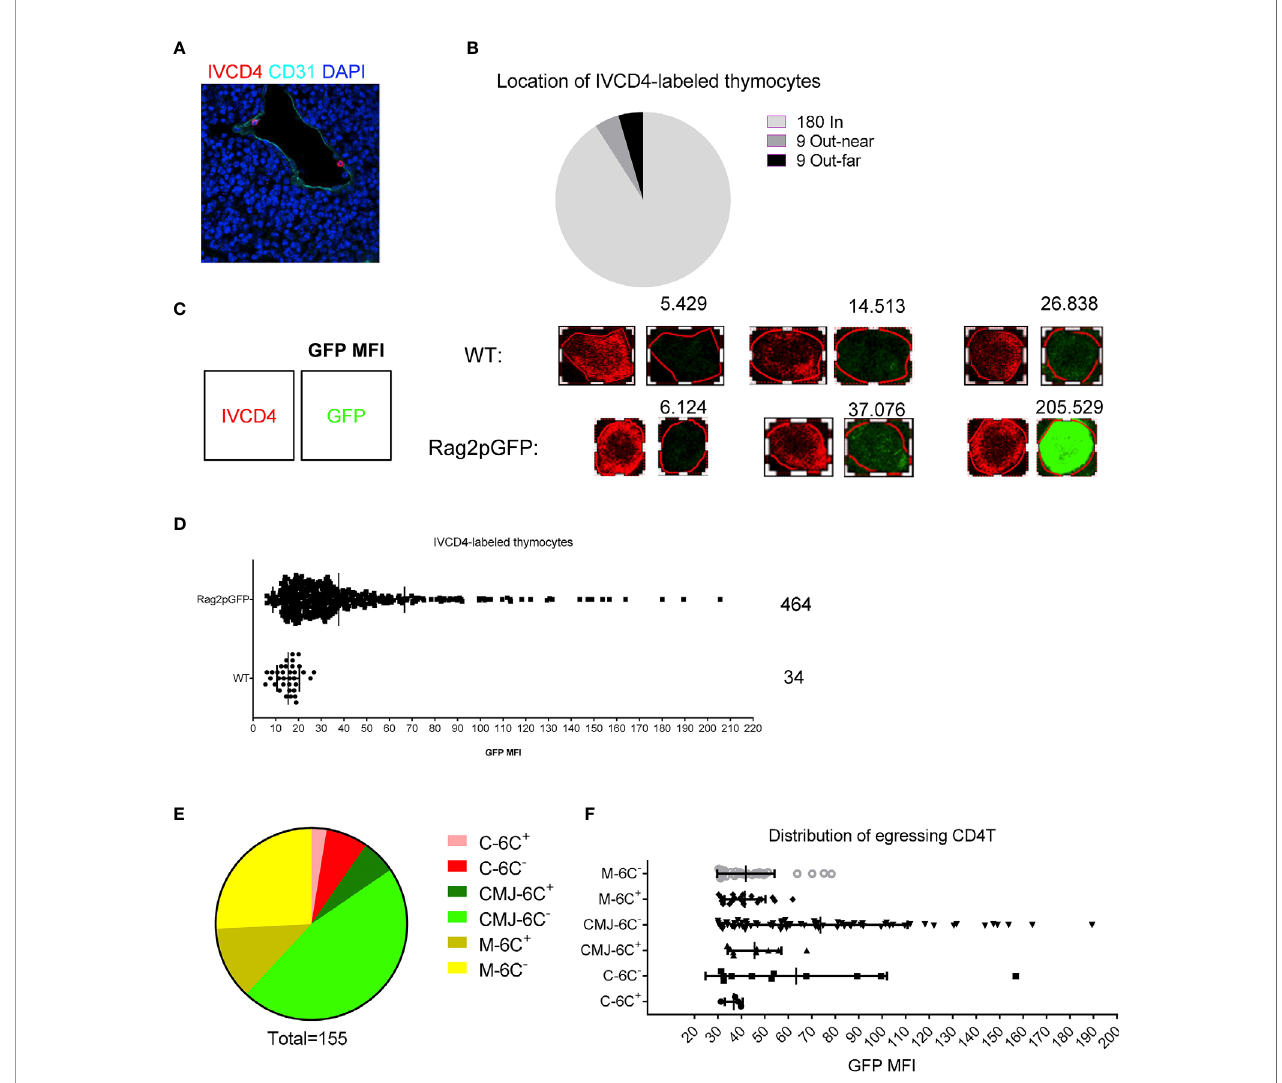
FIGURE 5 | Mature thymocytes emigrate through TPECs. (A) Representative image of IVCD4-labeled thymocytes is shown. (B) Graph displays the statistical analysis of the location of IVCD4-labeled thymocytes as in (A) Data from more than fi ve experiments were pooled for statistical analysis, n = 198. ( C – F) Location of egressing CD4 T + cells. (C) De fi ned the cell outline according to the CD4-PE signal (left), and numbers (upper) showed the calculated GFP MFI of the cell (right). Three representative cells with different GFP level are shown for each group. (D) Statistical analysis of the GFP MFI of IVCD4-labeled thymocytes in Rag2pGFP or WT mice. (E) Statistical analysis of the location of 155 egressing CD4 + T cells. C, cortex; M, medulla; CMJ, cortico-medullary junction; 6C + , Ly6C + vessels; 6C − , Ly6C − vessels. (F) GFP MFI of the egressing CD4 + T cells, grouped by the